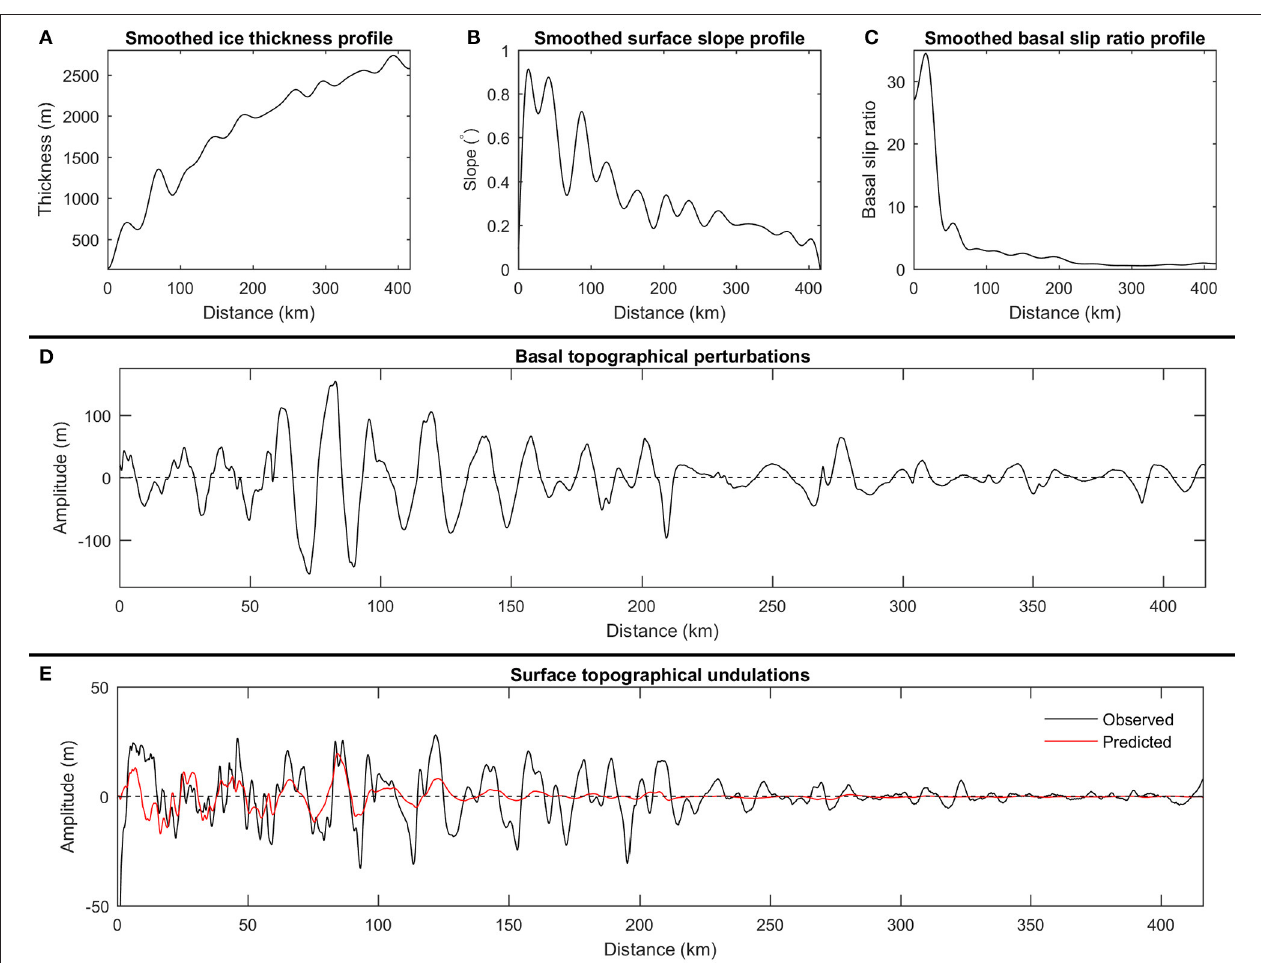
FIGURE 2 | Prediction experiment with the flowline in Figure 1 . Background variables: (A) ice thickness, (B) ice-surface slope, (C) basal slip ratio, (D) and basal topographical perturbations. (E) Observed and predicted surface topographical undulations, showing correspondence between some of their peaks and troughs.